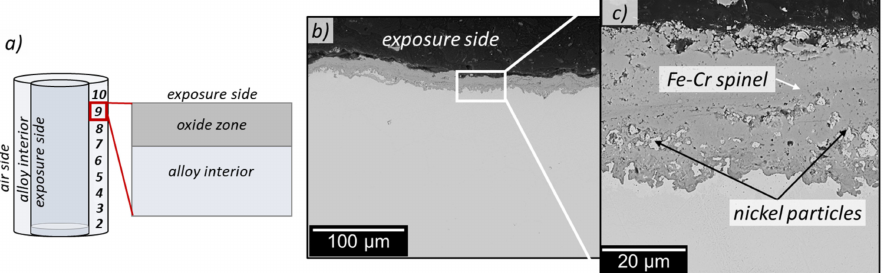
Figure 7. ( a ) schematic illustration of the tested vessel highlights the main corrosion regimes in the coldest section of the vessel after 4000 h exposure to evaporated alkali carbonate species. ( b ) Oxide scale on sample #9. ( c ) High-magnification of image b showing nickel as small fragments through the Fe-Cr